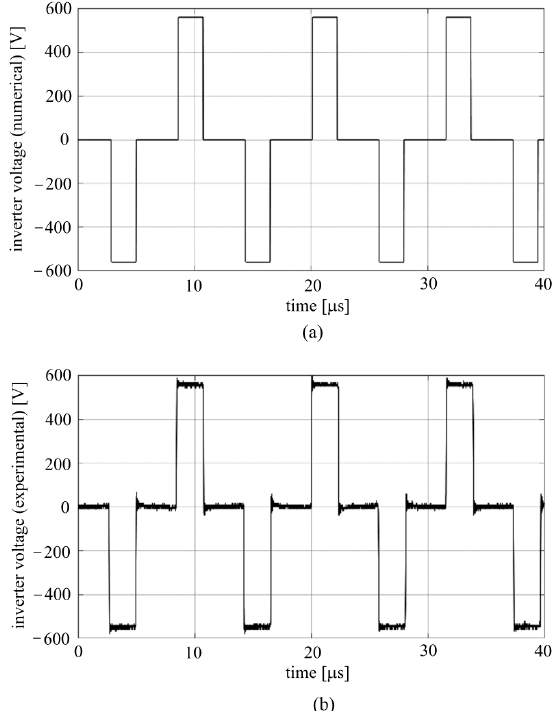
Figure 14. Output inverter voltage when a power load equal to a 3.5 kW is requested to IPT system: ( a ) numerical result; ( b ) experimental result. Figure 15a and b, respectively, show the output current waveforms of the inverter for the numerical and experimental analysis. A good agreement between numerical and experimental results is achieved in terms of the current as well. This allows validating the proposed design and performance of the IPT system.